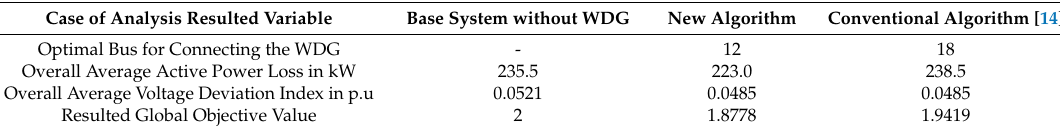
Table 1. Comparison of the main outcomes of the conventional [14] and proposed WDG placement algorithms, along with the corresponding results of the base system without WDG.